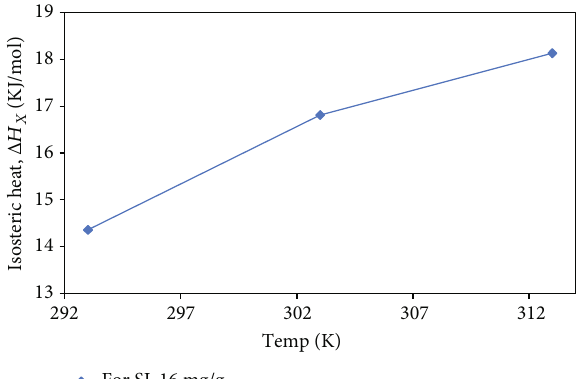
Figure 21: Plot between Δ H CV onto